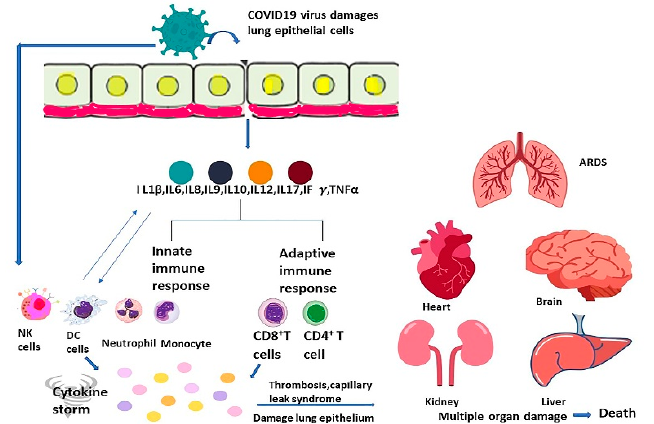
Figure 2. The virus infects the host and can then fuse with the host membrane and enter directly into the host cell through the cell surface or by endocytosis. Then, there is the immediate induction of immune response through chemokine, interferon, cytokines such as interleukin 6, interleukin 1 β , Interleukin 8, Interleukin 9, Interleukin 10, If γ , and tumor necrosis factor. The cytokine levels may increase, resulting in severe damage of tissue and cytokine storm. Cytokine storm develops rapidly with pro-inflammatory cytokines’ overproduction and excessive immune cell activation resulting in ARDS, DIC, capillary leak syndrome, failure of multiple organs, and even death. Notes: Arrow denotes follow-up consequences and double arrow mean interchangeable